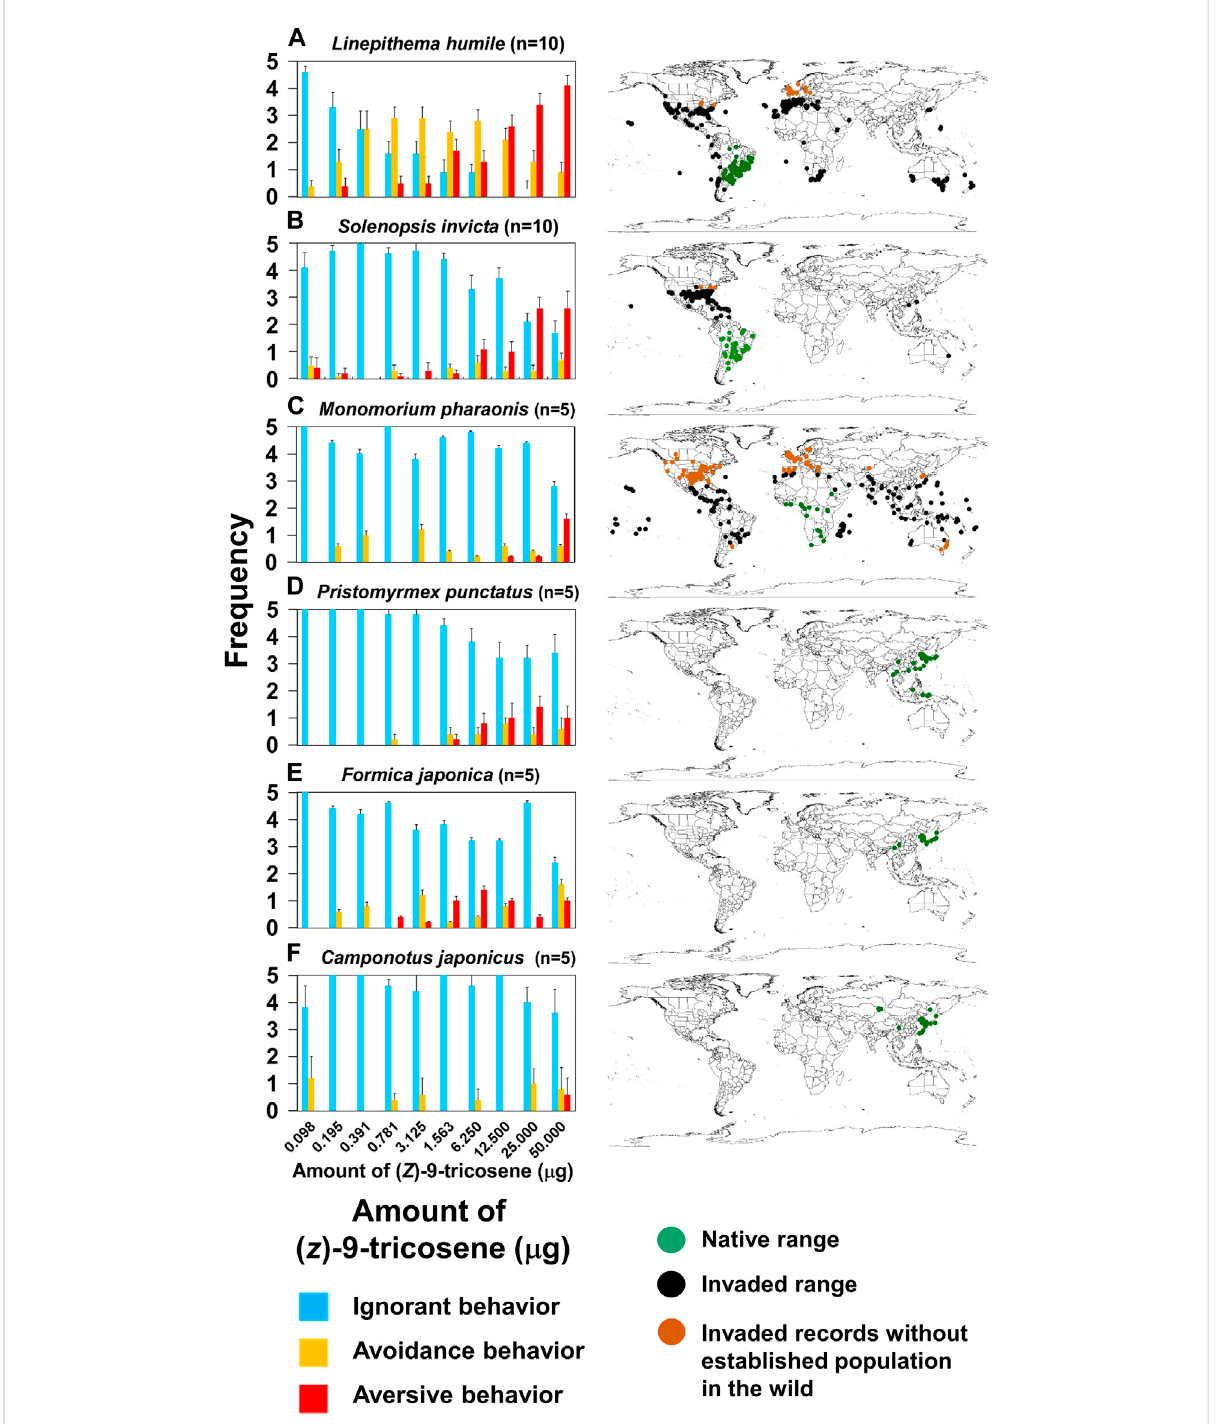
Behavioral effects of ( Z )-9-tricosene on 6 ant species. (A – F) (Left) Date on L . humile , S . invicta , P. punctatus , M. pharaonis , F. japonica, and C. japonicus . (A – F) (Right) Global distributions in 2019. Green and black dots indicate native and invaded ranges, respectively. Brown dots indicate invaded records without established populations (see https://antmaps.org/) (Janicki et al., 2016; Guénard et al.,